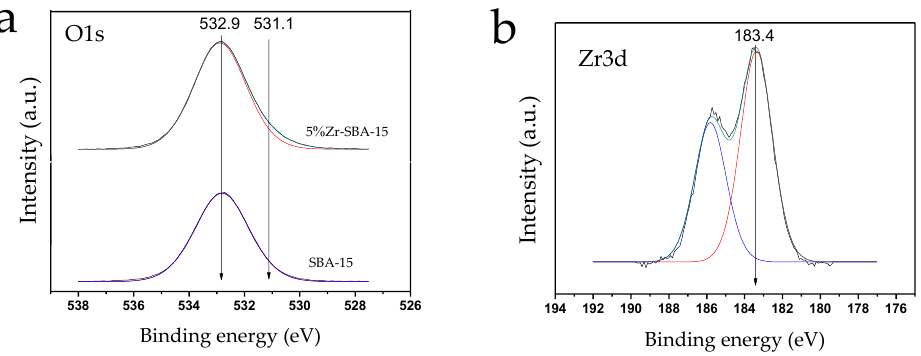
Figure 3. The O1s ( a ) and Zr3d ( b ) XPS spectra of 5%Zr-SBA-15. The O1s spectra of pure SBA-15 and 5%Zr-SBA-15 are characterized by the signals at ~532.9, which correspond to Si 4+ in SiO 2 . For 5%Zr-SBA-15 the shoulder in the region of lower binding energies (531.1 eV) is present, which can be attributed to the oxygen within zirconium oxide (Figure 3). The acidic properties of 5%Zr-SBA-15 samples were studied using pyridine adsorption coupled with FTIR. The IR spectra of 5%Zr-SBA-15 before pyridine adsorption reveal several absorption bands at 3730, 3739–3741, and 3745–3747 cm − 1 , which correspond to the stretching vibrations of the Si-OH groups (Figure 4). For a pure silicon oxide, one band is usually observed, which corresponds to isolated Si–OH groups [39,40]. The heterogeneity of the OH groups of the studied sample is probably associated with the inclusion of zirconium ions in the silicate framework [41]. Since the diameter of Zr 4+ ions significantly exceeds the diameter of Si 4+ ions, upon the substitution in the framework, the Zr–O–Si bond length differs significantly from the Si–O–Si bond length, which leads to structural micro stresses inside the lattice, weakening of the Si-O-Zr–O–H bond, and increasing the Bronsted acidity of silicate materials modified with zirconium [42,43].